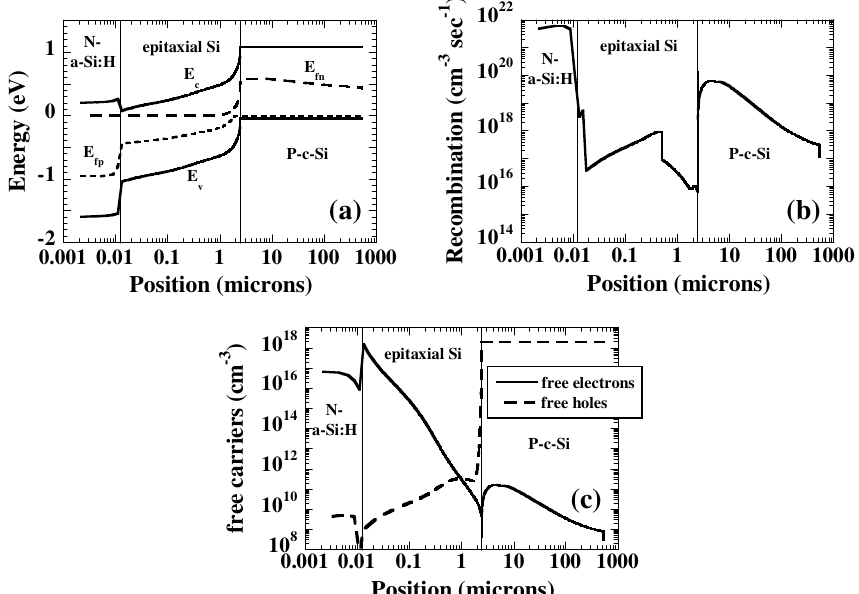
Fig. 5. (a) The energy band diagram, (b) the recombination rate and (c) the free carrier population as a function of position in the device for the solar cell having a 2.4 μ m epitaxial silicon intrinsic layer under AM1.5 light and short-circuit